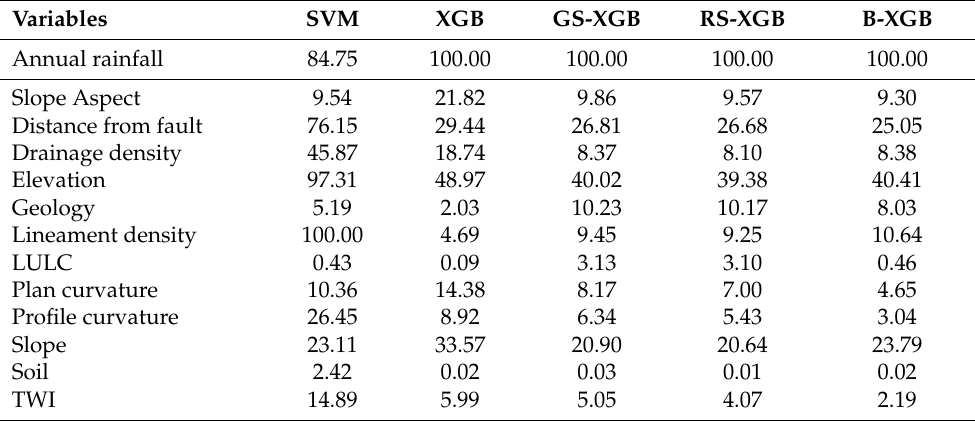
Table 4. Importance